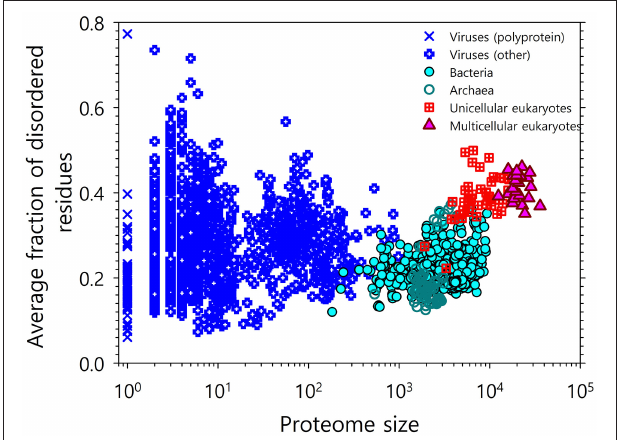
FIGURE 1 | Correlation between the intrinsic disorder content and proteome size for 3,484 species from viruses, archaea, bacteria, and eukaryotes. Each symbol indicates a species. There are six groups of species in total: viruses expressing one polyprotein precursor (open blue circles), other viruses (blue crosses), bacteria (green circles), archaea (red open circles), unicellular eukaryotes (brown open squares), and multicellular eukaryotes (yellow triangles). Each viral polyprotein was analyzed as a single polypeptide chain, without parsing it into the individual proteins before predictions. The proteome size is the number of proteins in the proteome of that species shown in the log base. The average fraction of disordered residues is calculated by averaging the fraction of disordered residues of each sequence over the all sequences of that species. Disorder prediction is evaluated by PONDR ® VSL2B. This plot is based on the data published in [3].